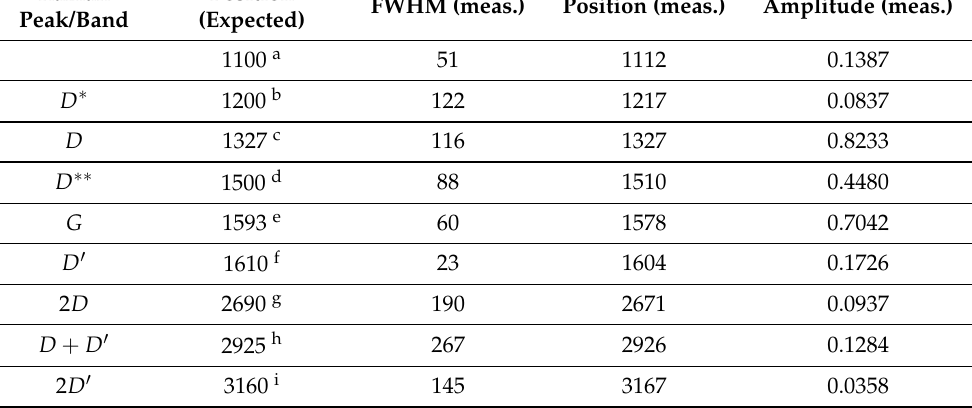
Table 2. Peaks deconvolution of the Raman spectrum at 293 K shown in Figure 5. From left: conventional Raman peak label; expected peak position (cm − 1 ), full width at half maximum (cm − 1 ), peak position (cm − 1 ) and relative peak amplitude (arbitrary units). The latter three quantities have been derived by peak analysis in this work. The expected peak positions are given and referenced with superscript labels